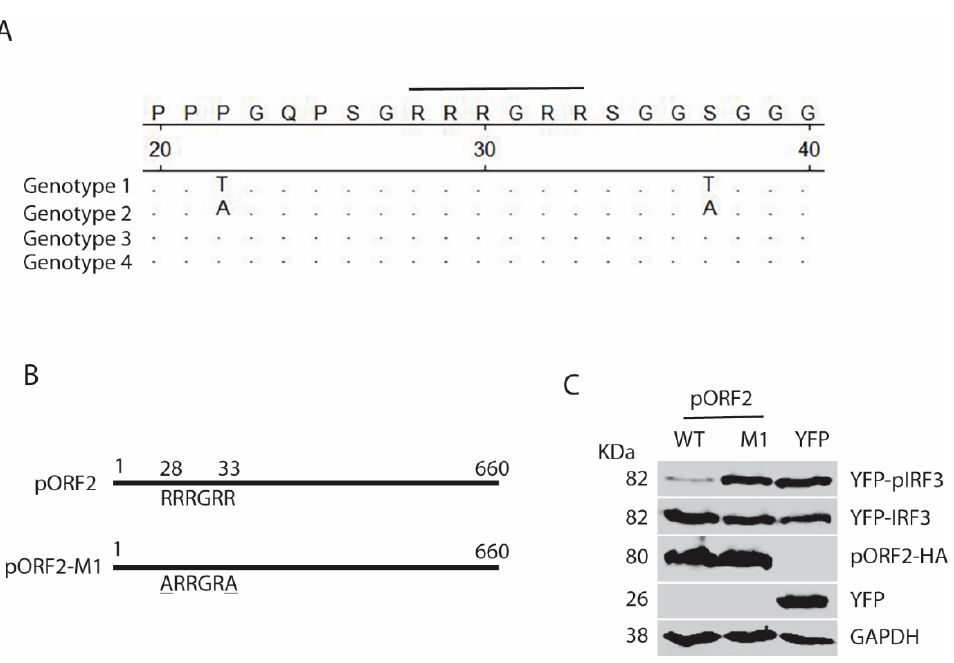
Figure 8. The arginine-rich motif aa28-33 (RRRGRR) in the full-length capsid protein is indispensable for the inhibition of IRF3 phosphorylation. ( A ) The arginine-rich motif aa28-33 (RRRGRR) is conserved across the four genotypes of HEV that infect humans (GenBank accession numbers for the genotype 1 to 4 strains in the alignment are: LC061267.1, KX578717.1, AF444003.1, and AB220979.1, respectively). The top amino acid sequence denotes the consensus of the four genotypes. The line above the residues denotes the arginine-rich motif aa28-33 (RRRGRR). The residues that are identical to the consensus sequence are denoted by “.” in the alignment. The numbers below the consensus sequence indicate the position in the full-length pORF2. ( B ) Schematic illustration of the full-length pORF2 and the point mutations in the arginine-rich motif: R28A and R33A. The alanine residues in the mutation sites of pORF2-M1 are underlined. ( C ) Mutant pORF2 protein loses the inhibition of IRF3 activation. HEK293-IRF3 cells were transfected with wild-type (WT) pORF2, pORF2-M1, or YFP plasmids. The cells were treated with poly(I:C) for 8 h before harvested for WB.